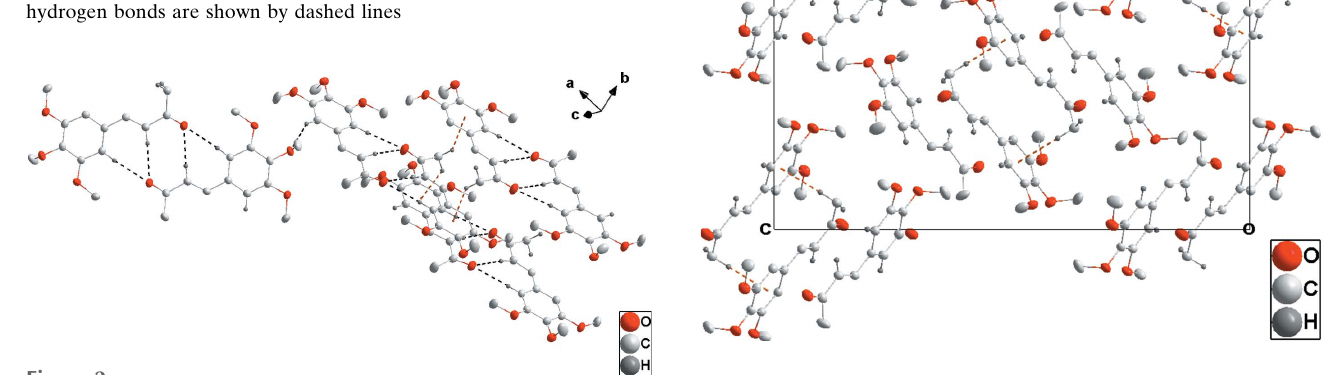
Figure 3 Packing viewed along the a -axis direction.